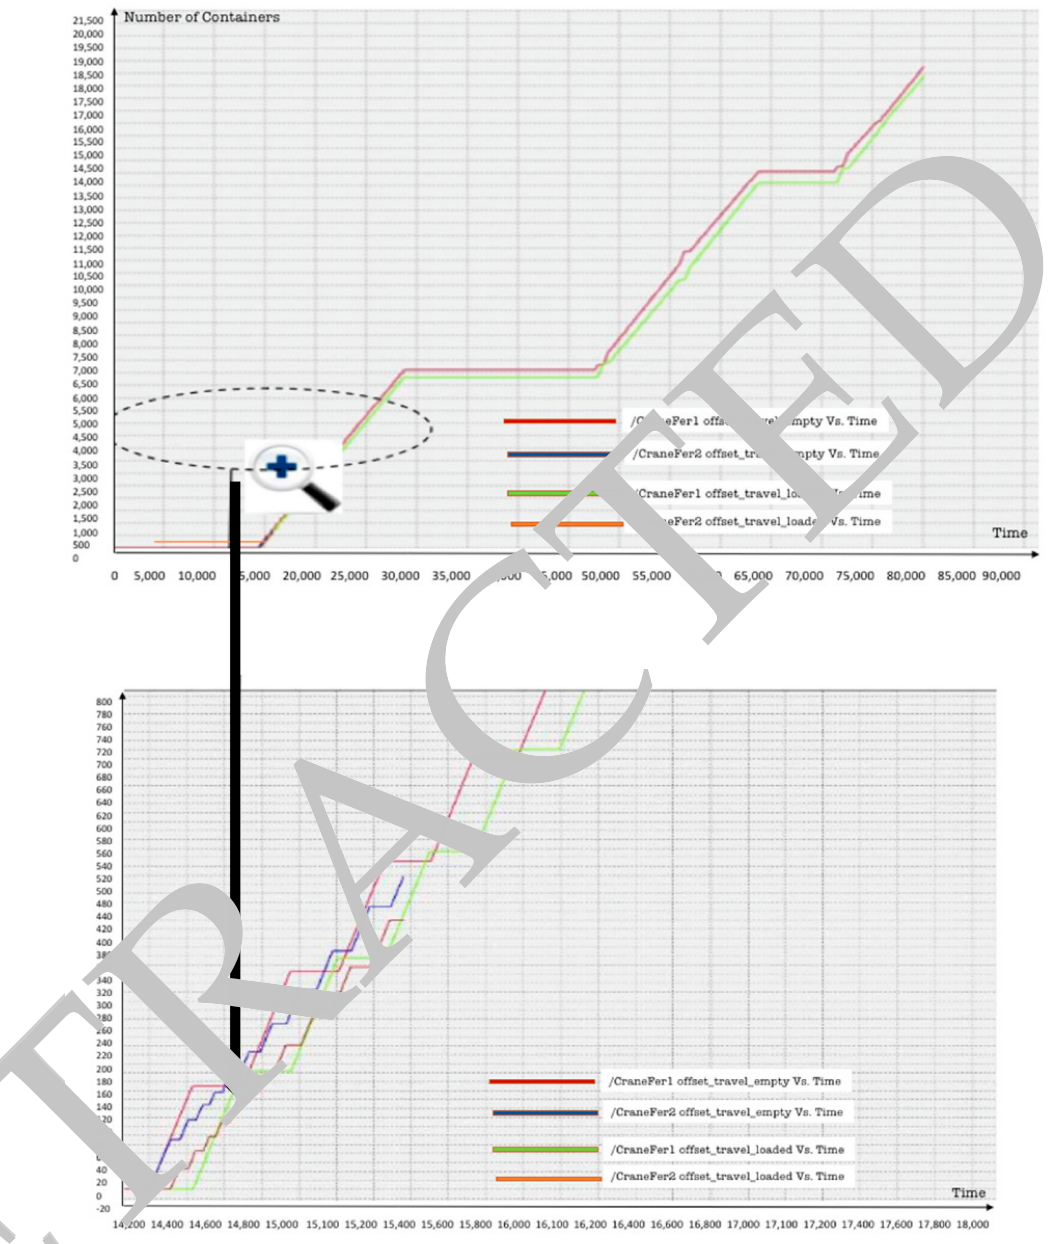
Figure A5. Movement rate of the two railway gantries of the multimodal terminal for Scenario